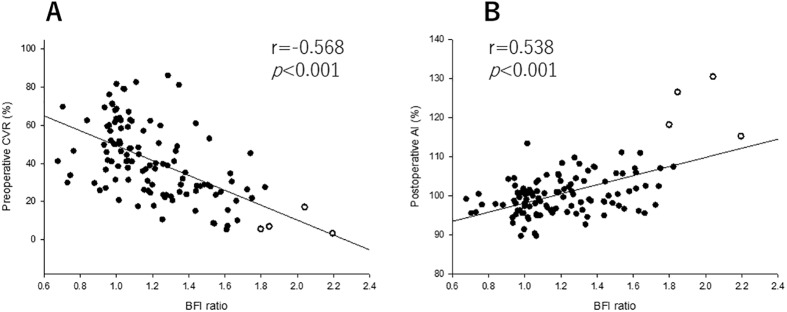
The BFI ratio was correlated with preoperative CVR (A). The BFI ratio was also correlated with the postoperative AI (B). Open circles indicate patients with HPS after CAS.